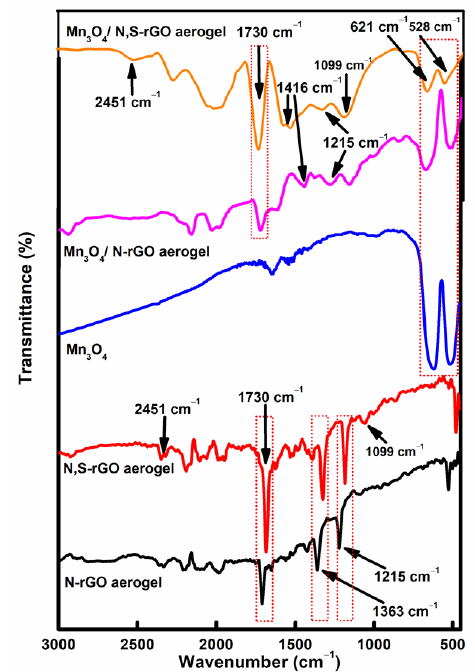
Figure 6. FTIR spectra of N-rGO aerogel, N,S-rGO aerogel, Mn 3 O 4 nanoparticles, Mn 3 O 4 /N-rGO aerogel, and Mn 3 O 4 /N,S-rGO aerogel.